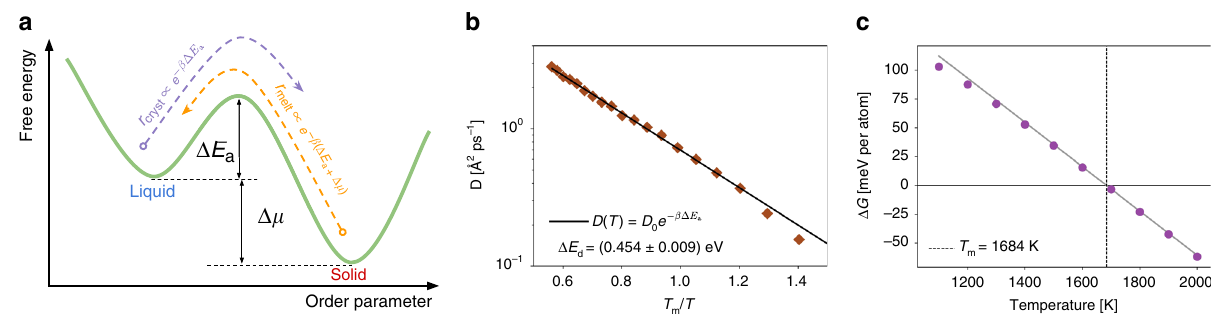
Fig. 2 Wilson – Frenkel model. a Free-energy landscape for solidi fi cation according to the Wilson-Frenkel model. The activation energy for solidi fi cation is given by Δ E a , while Δ μ is the chemical potential difference between the liquid and solid. Atomic events contributing to crystal growth are thermally activated processes occurring with rate r cryst for atoms moving from the liquid to the solid and r melt for atoms moving from the solid to the liquid. b Arrhenius plot of the liquid diffusivity as a function of temperature. The solid black line is the result of a least-squares fi t to the data for T ≥ T m . The energy barrier for diffusion in the liquid Δ E d is used as an input parameter in the Wilson – Frenkel model. c Difference in free energy Δ G between the solid and liquid phases. The thermodynamic melting temperature occurs at Δ G ( T m ) = 0. The solid gray line is a guide to the eye to accentuate deviations from the linear behavior.